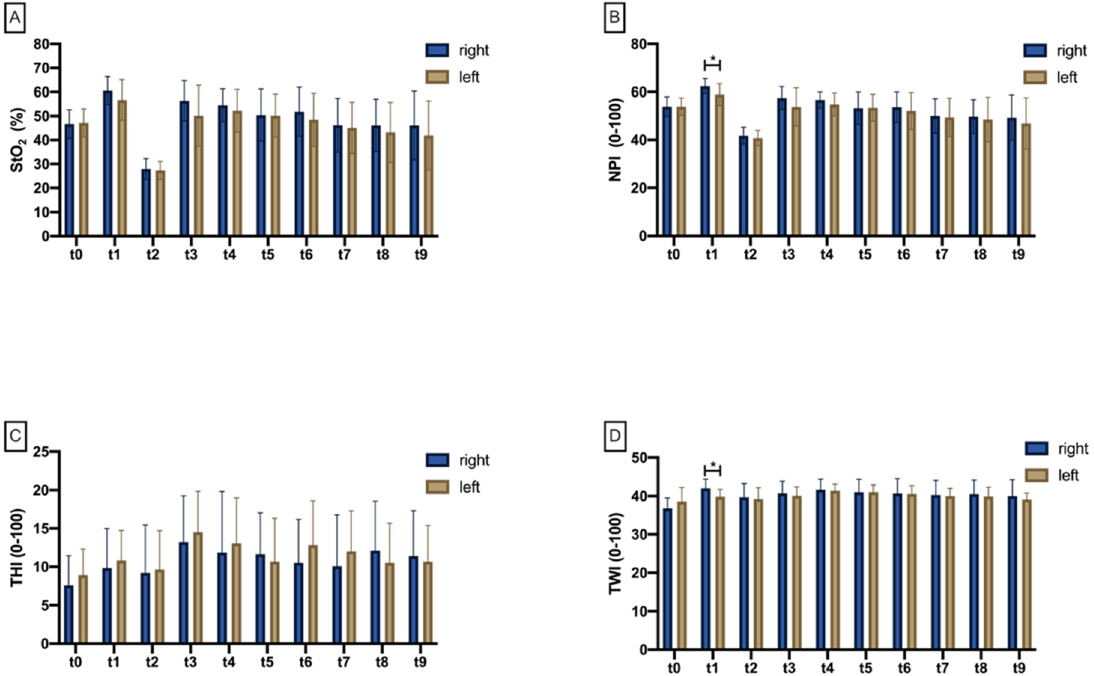
Figure 3. Bar chart with means (±SD) showing ( A ) tissue oxygenation saturation (StO 2 ), ( B ) near- infrared perfusion index (NPI), ( C ) tissue hemoglobin index (THI), and ( D ) tissue water index (TWI) at different measurement timepoints (t1–t9). Crossbars with asterisks mark significant differences.